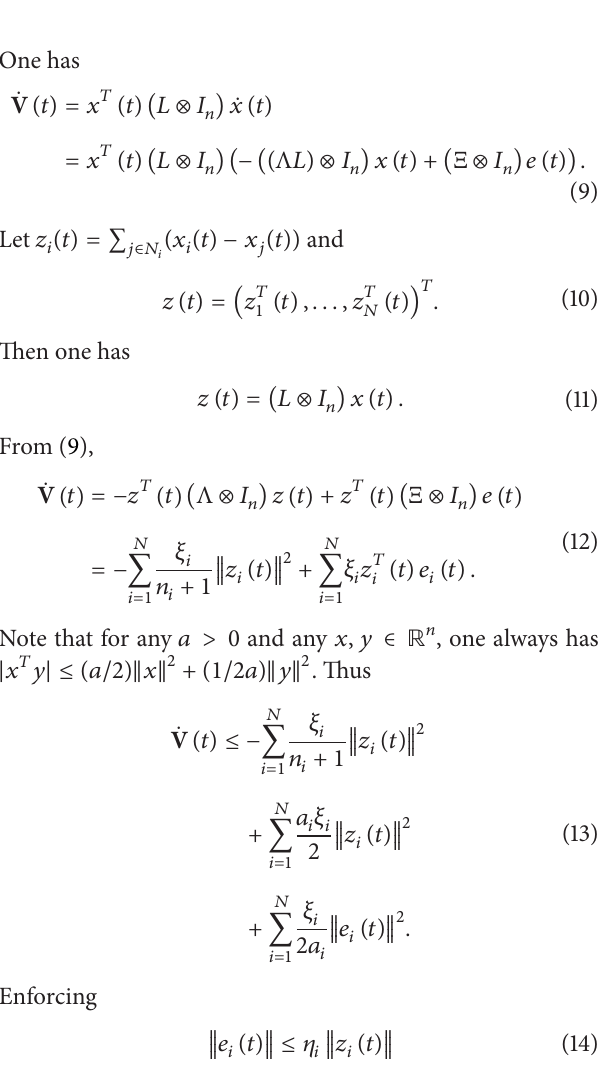
Figure 2: Communication topology and trajectories of agents.